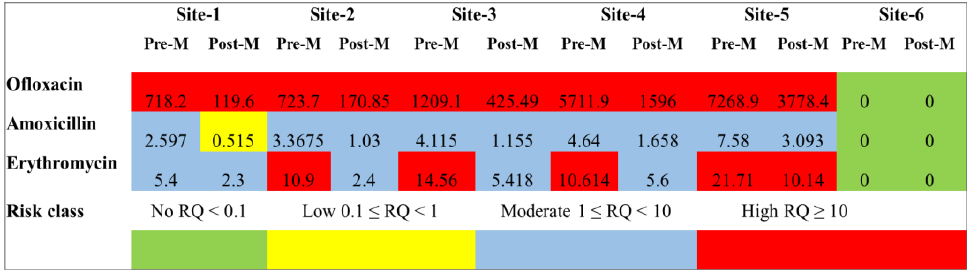
Figure 5. Risk Quotient of antibiotics compounds in the Yamuna River.